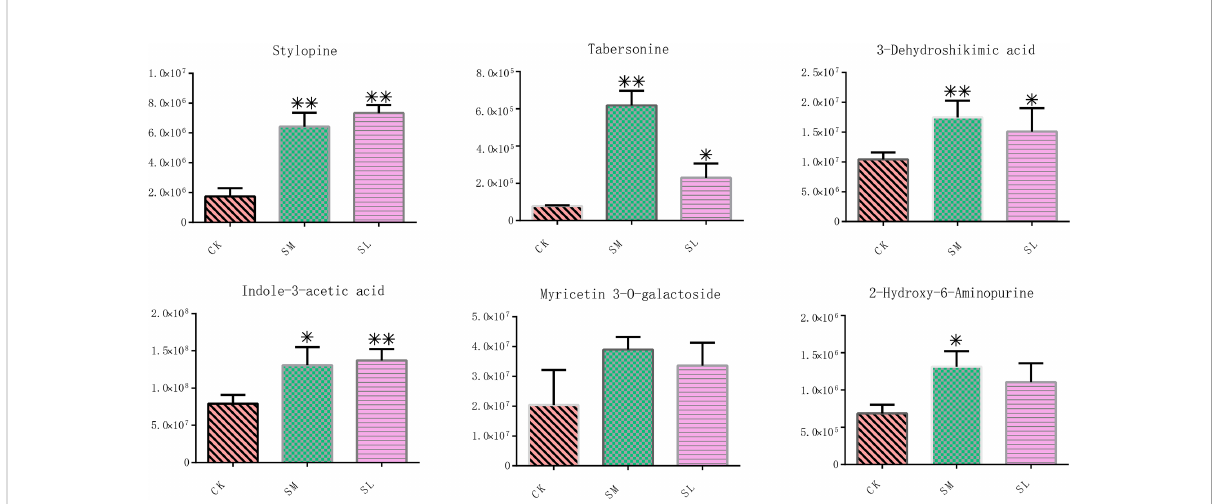
FIGURE 8 Relative contents of six metabolites with the highest correlation coef fi cients with IibZIP genes in leaves of I. indigotica after salt stress treatment. Error bars denote the standard deviation of three replicates (*p < 0.05, **p <